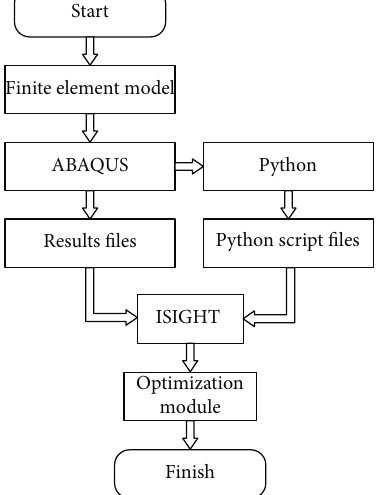
Figure 6: Structure analysis and optimization fl ow chart based on